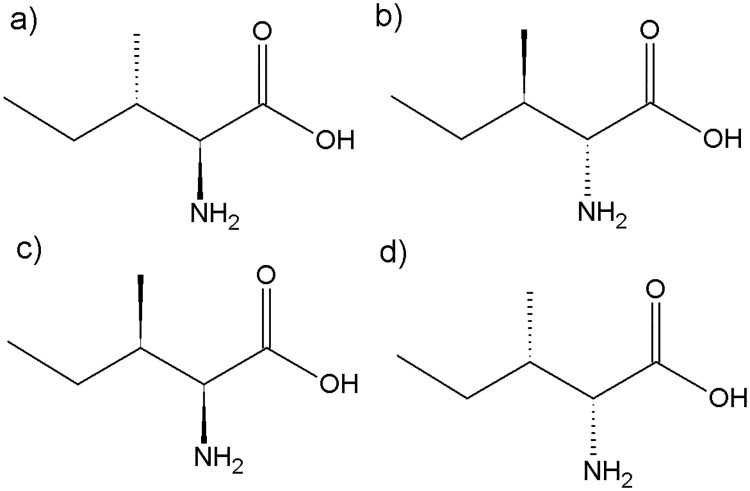
Chemical structures of the isomers of isoleucine (a) L-isoleucine ((2S,3S)-2-amino-3-methylpentanoic acid), (b) D-isoleucine ((2R,3R)-2-amino-3-methylpentanoic acid)) (c) L-allo-isoleucine ((2S,3R)-2-amino-3-methylpentanoic acid)) and (d) D-allo-isoleucine ((2R,3S)-2-amino-3-methylpentanoic acid).